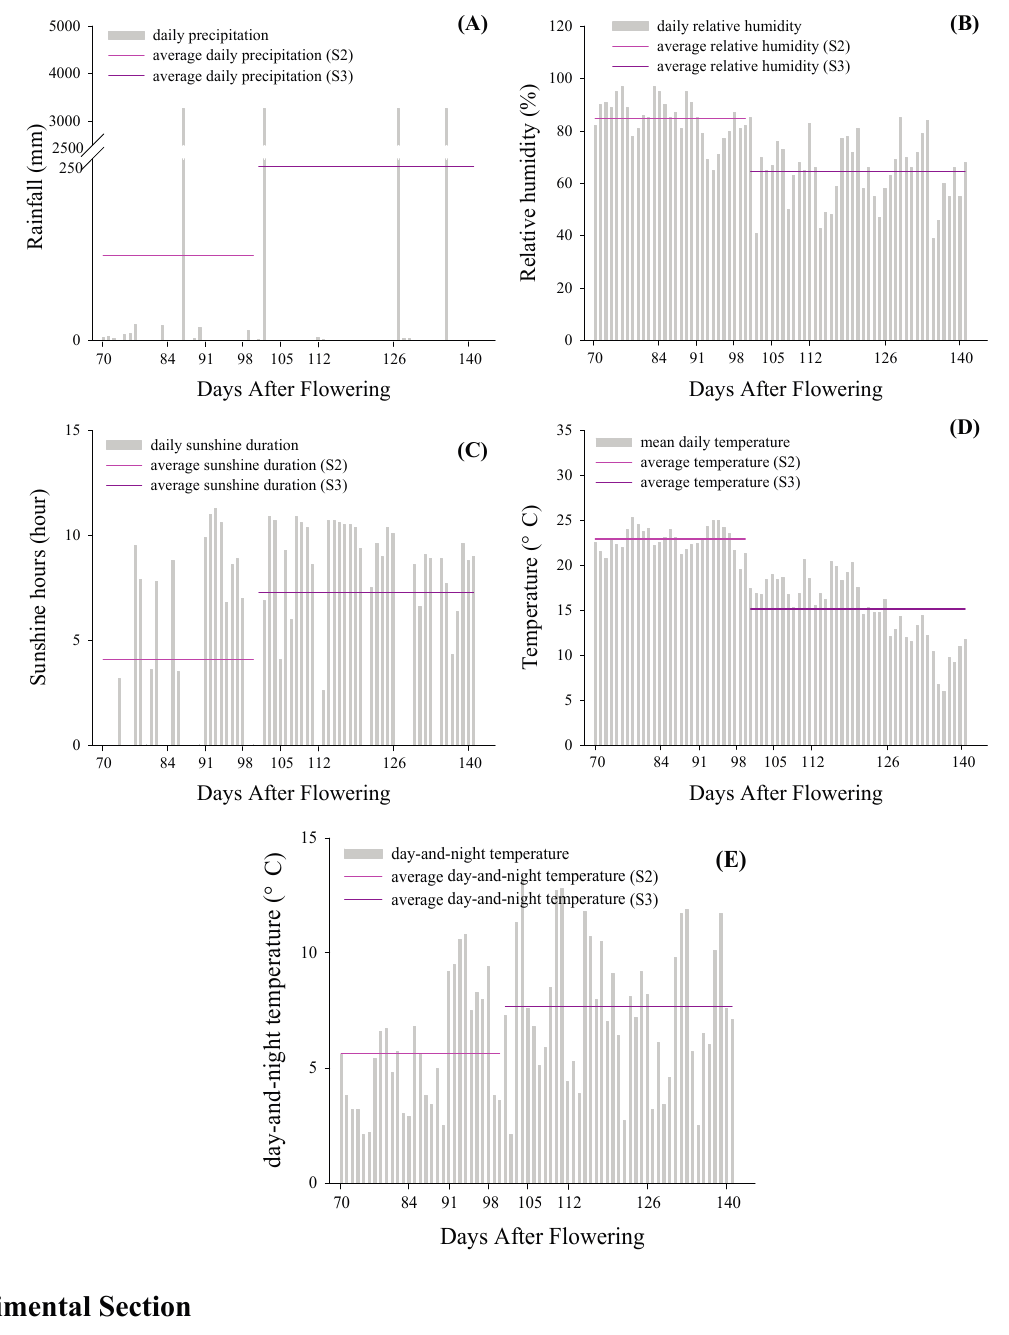
Figure 6. Rainfall ( A ), relative humidity ( B ), sunshine hours ( C ), mean daily temperature ( D ) and day-and-night temperature ( E ) during veraison (stage 2) and maturation period (stage 3) in 2010, Penglai region, Shandong Province,